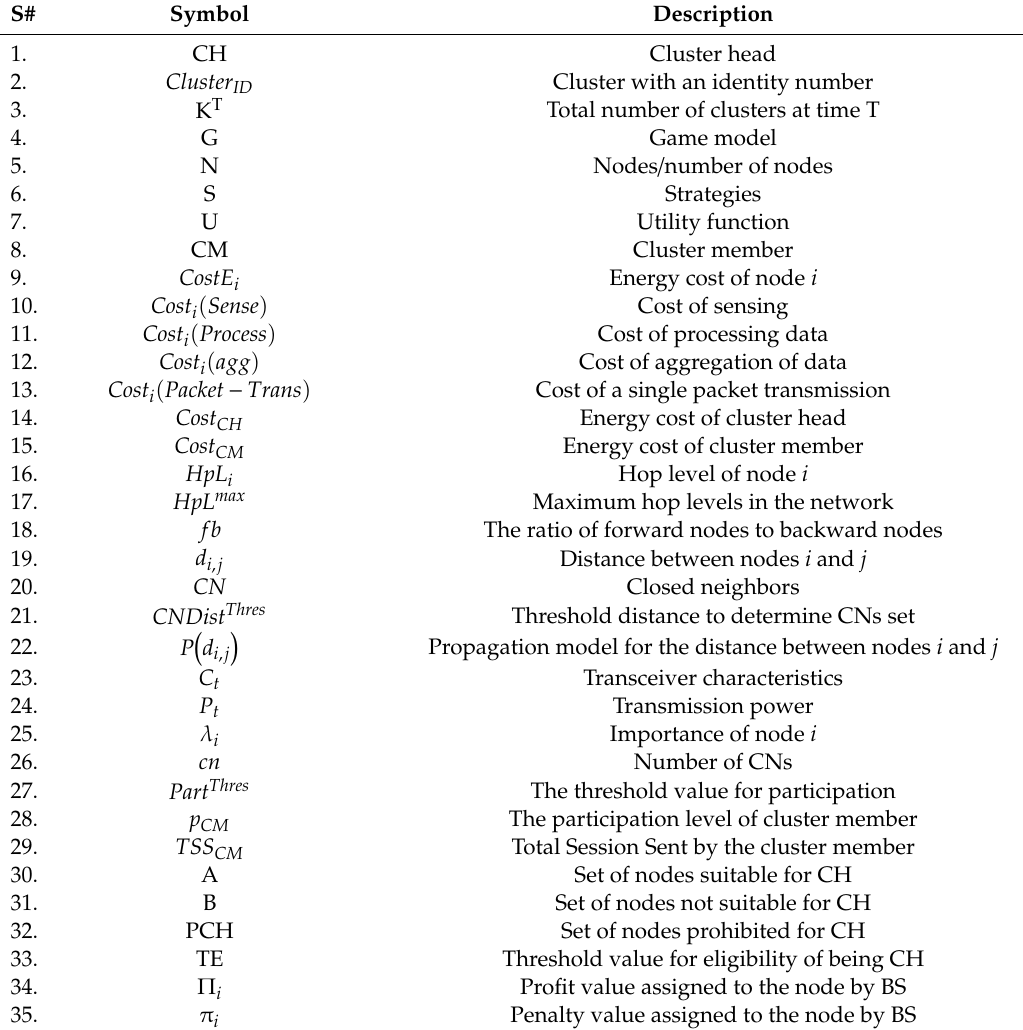
Table 2. List of